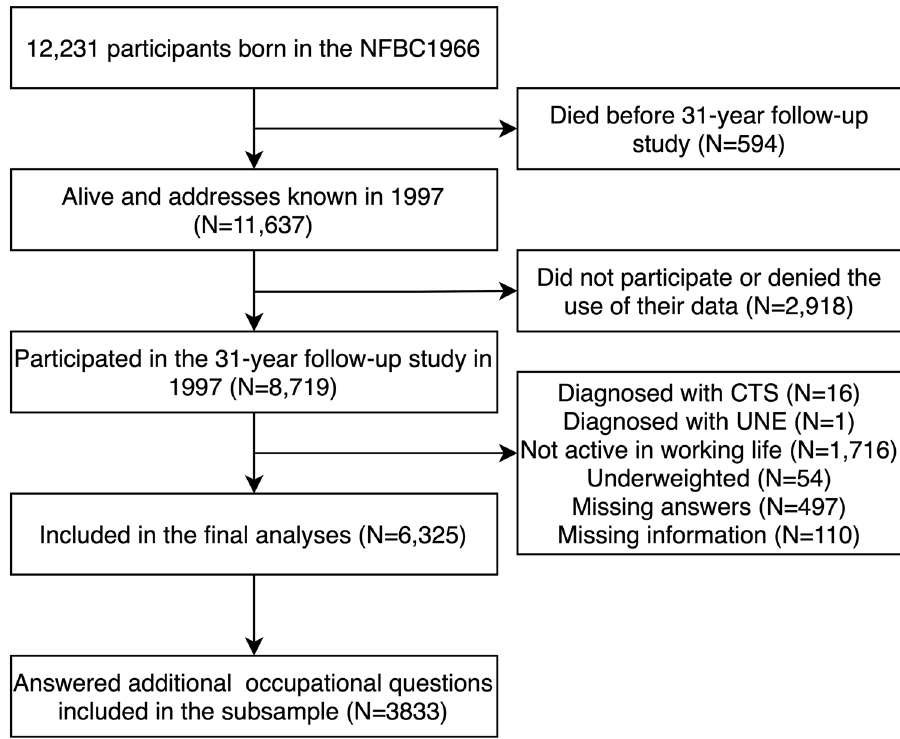
Figure 1. Flowchart of study population (the Northern Finland Birth Cohort of 1966, NFBC1966; carpal tunnel syndrome, CTS; ulnar nerve entrapment,